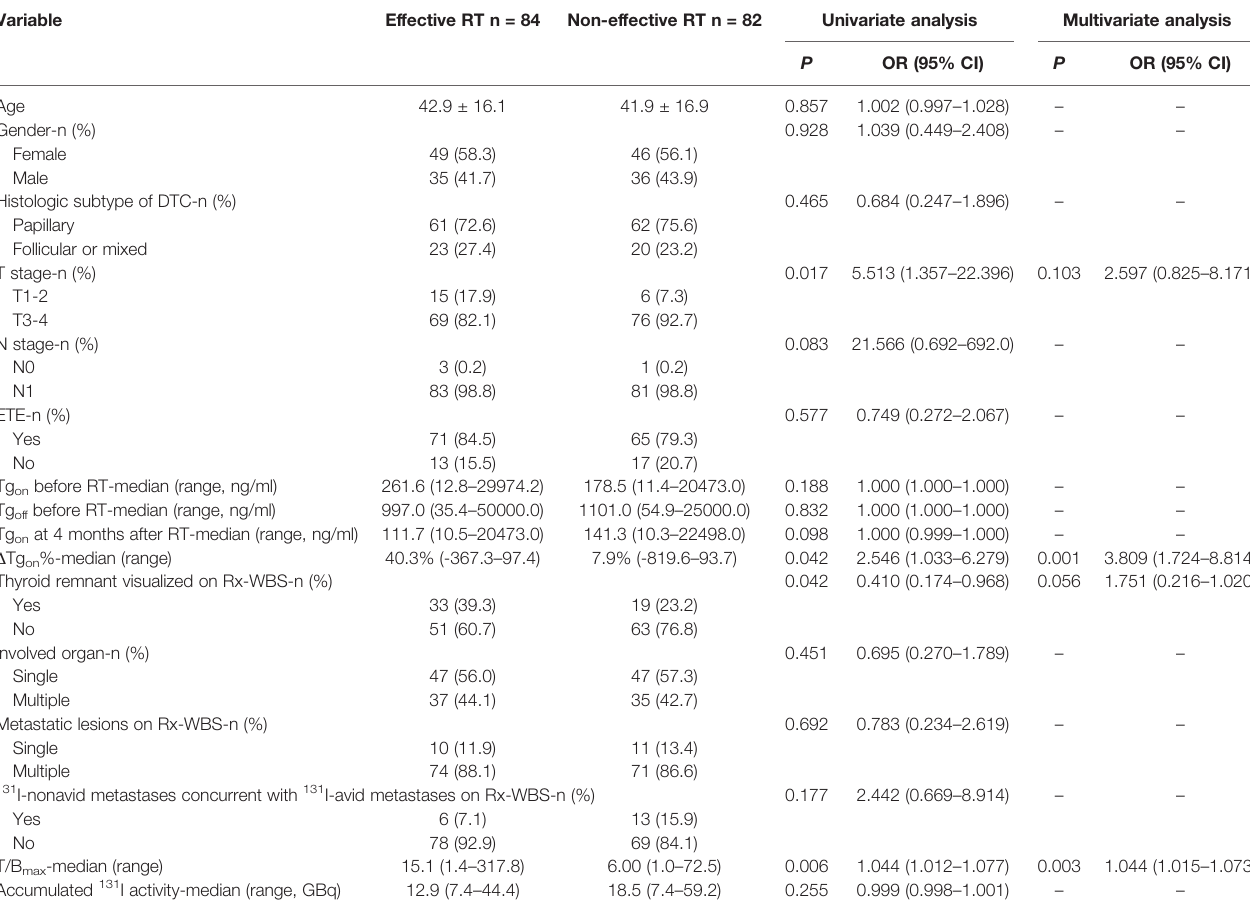
TABLE 2 | Univariate analysis of factors potentially associated with biochemical response to next radioiodine treatment in 166 former courses. Variable